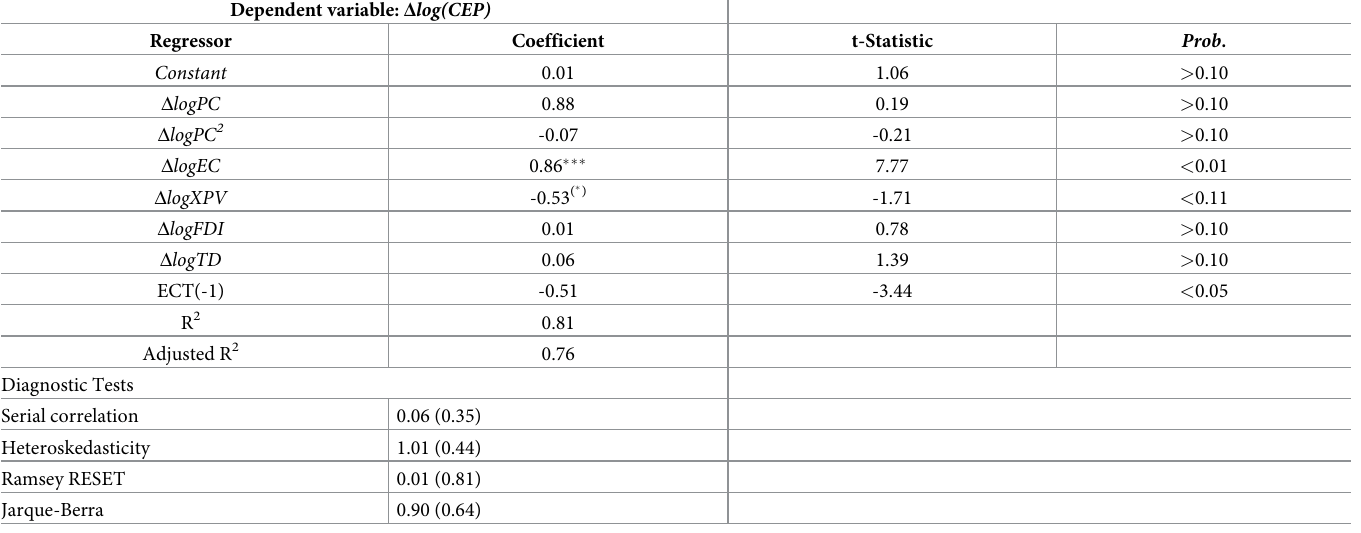
Table 6. Short-term results based on